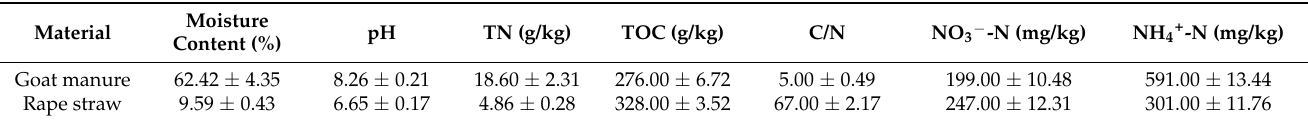
Table 1. Physical and chemical indicators of composting raw materials (moisture content, pH, total organic carbon, C/N, NH 4+ -N, NO 3 −